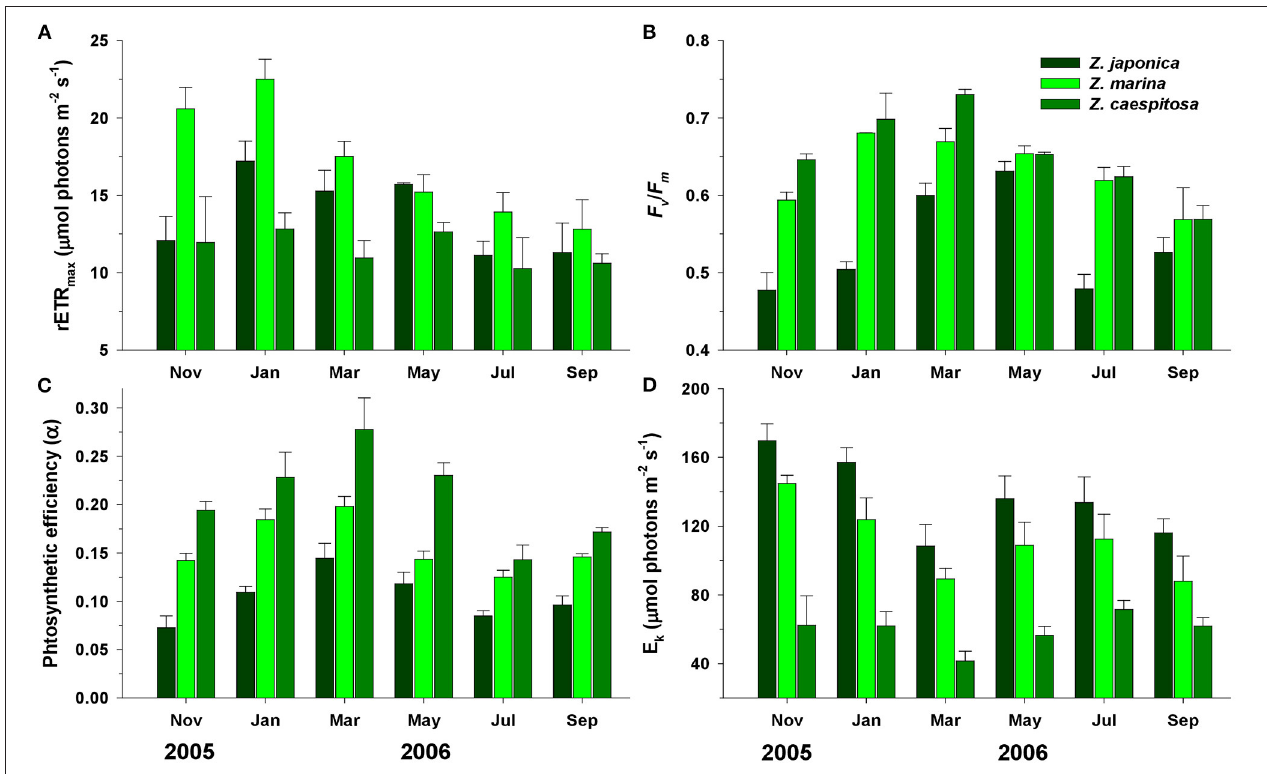
FIGURE 8 | Seasonal variations in maximum relative transport rate (rETR max ; A ), maximum quantum yield ( F v /F m ; B ), photosynthetic efficiency ( α ; C ), and minimum saturating irradiance (E k ; D ) of Z. japonica , Z. marina , and Z. caespitosa at Koje Bay. Values are expressed as mean ± SE ( n =